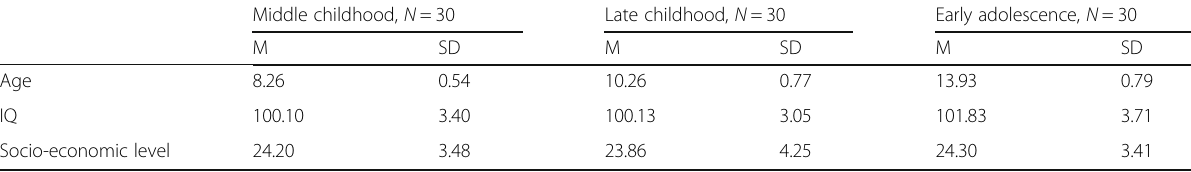
Table 1 The characteristics of the participants with reading disability Middle childhood, N =